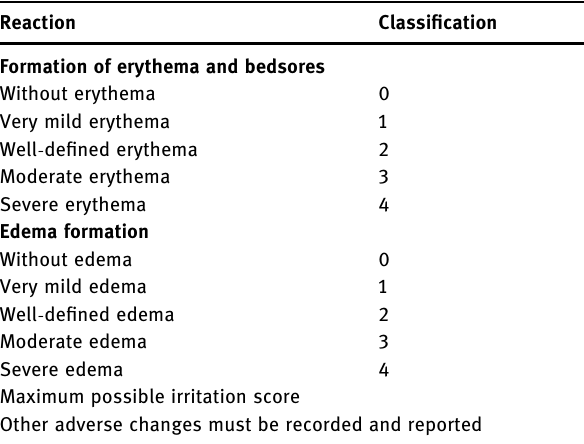
Table 2: Tissue reaction index Reaction Classi fi cation